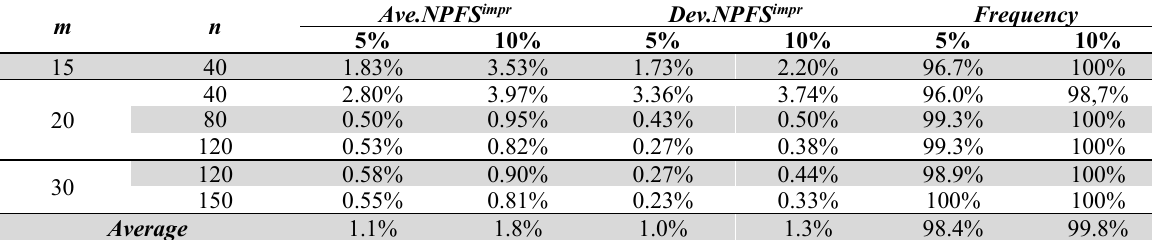
NPFS solution improvement over PFS